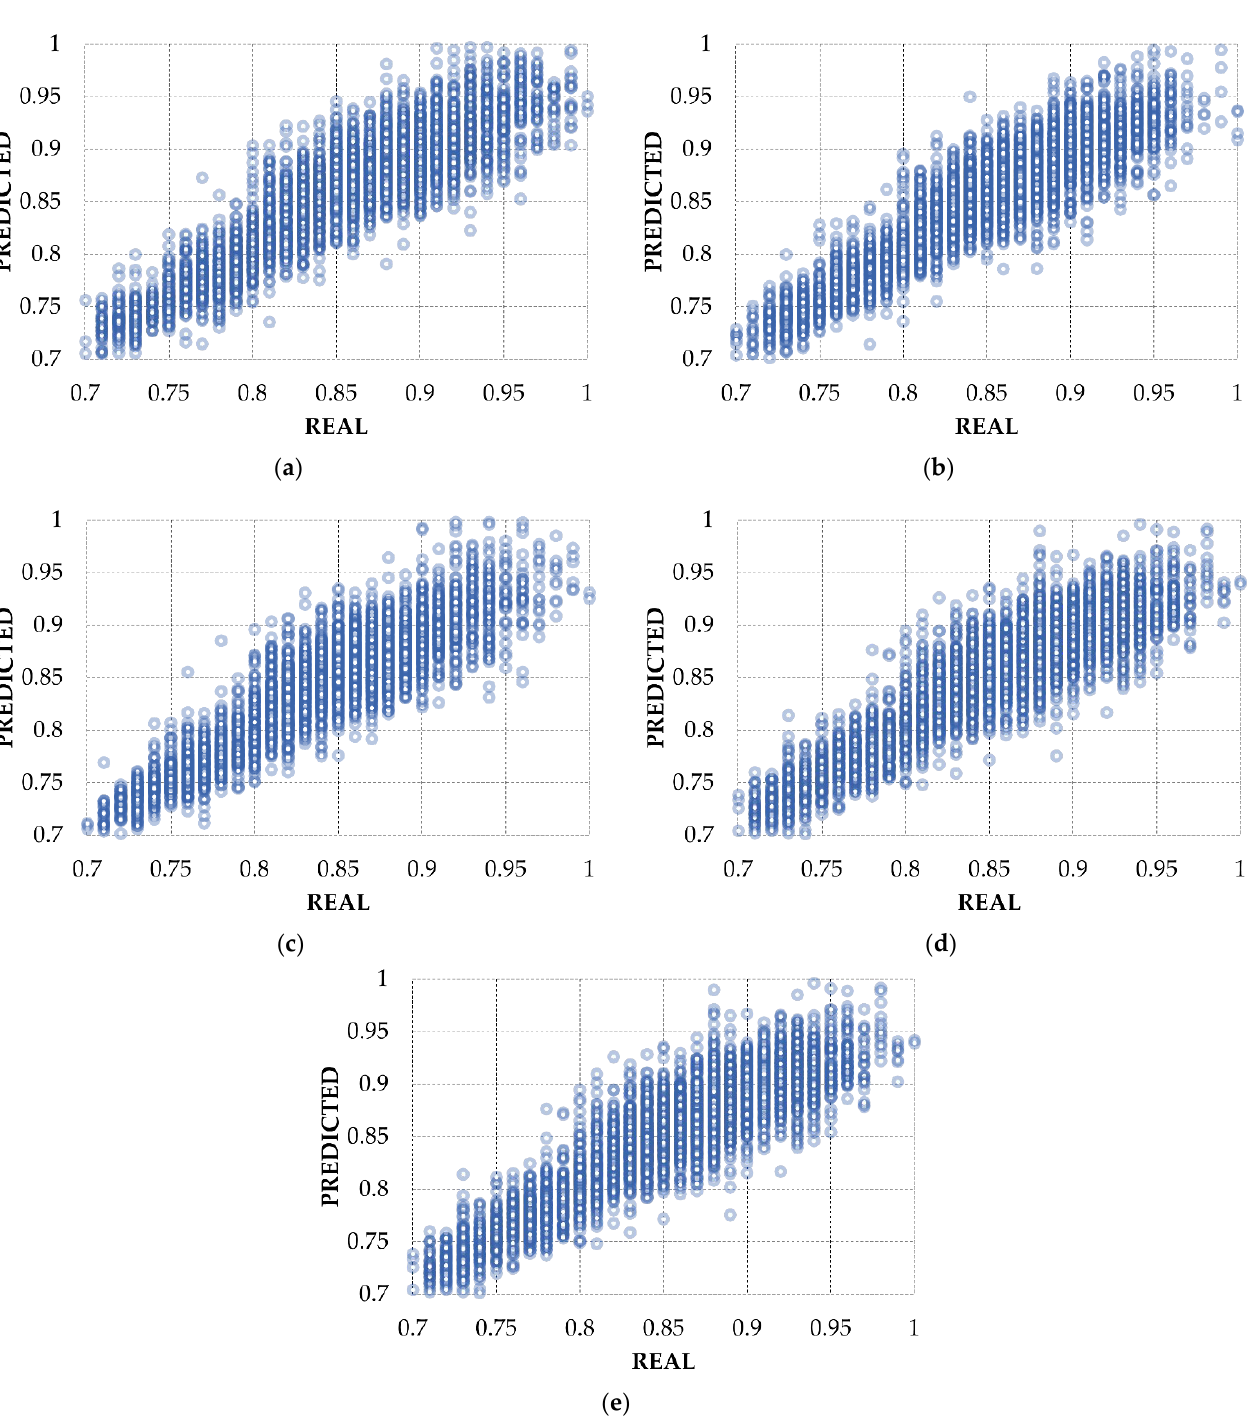
Figure 7. Scatter plots of predicted and real values of relative pump speeds for Network2. ( a ) PU2 ( b ) PU4 ( c ) PU6 ( d ) PU8 ( e ) PU10.